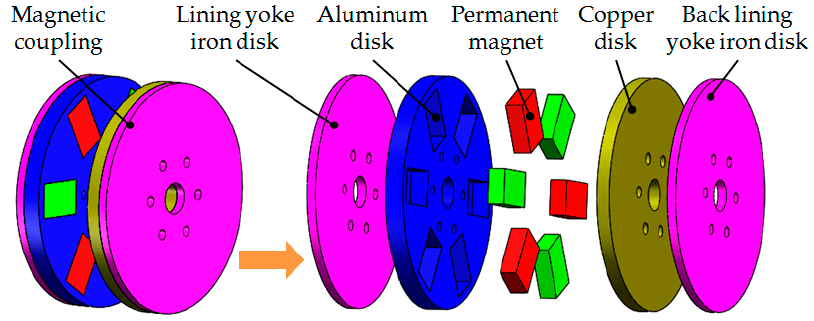
Figure 1. Structure of magnetic coupling.